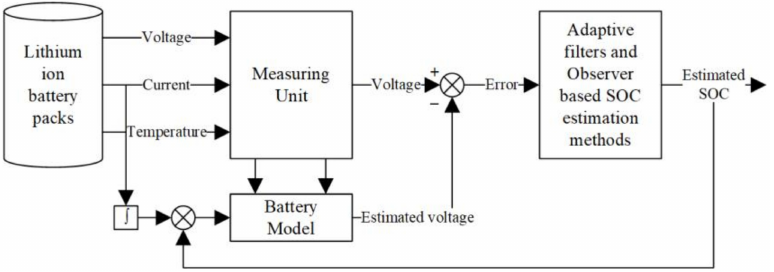
Figure 7. General diagram of model-based SOC estimation